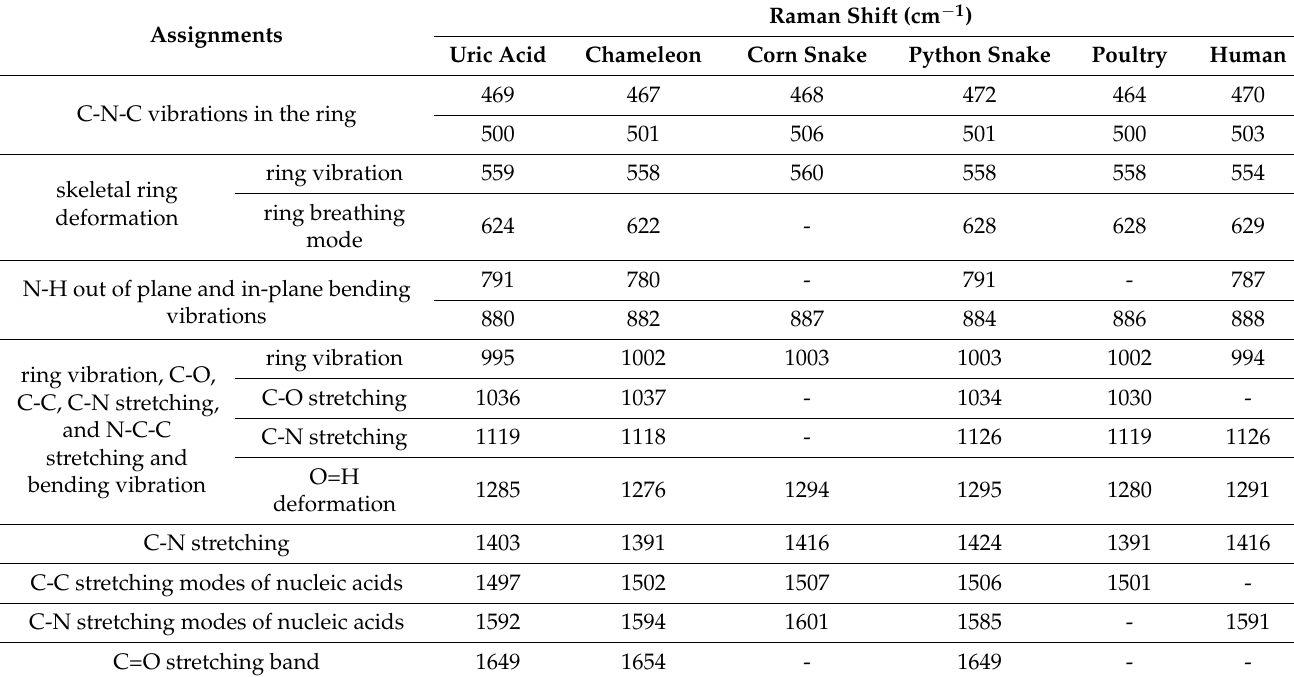
Table 1. Raman bands assignments of samples vs. uric